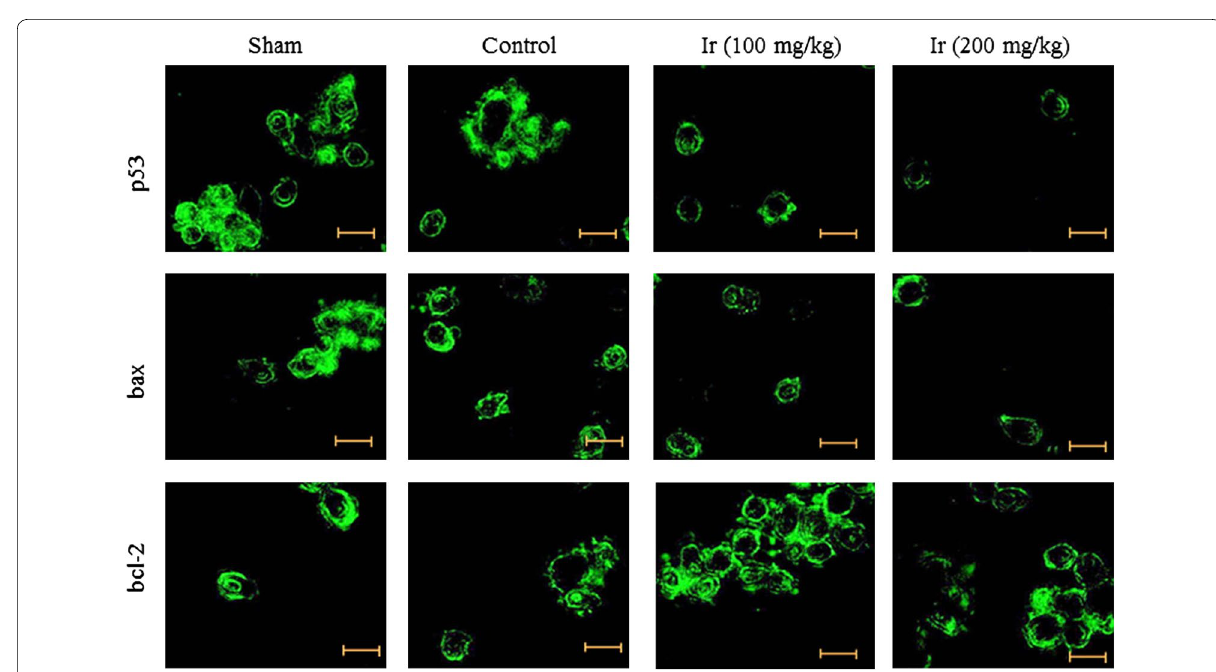
Fig. 9 Immunofluorescence of p53, bcl-2 and bax. The representative images were obtained from six independent experiments. Scale bar is 60